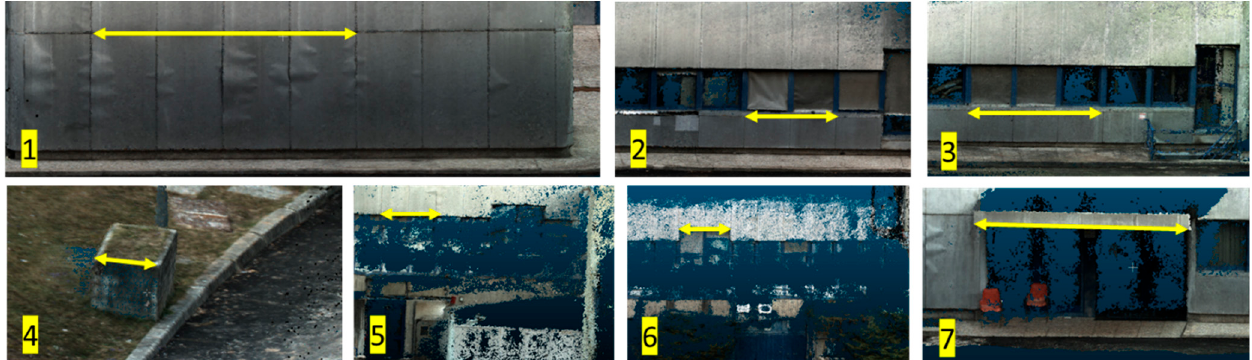
Figure 12. Histogram and distribution of the signed Euclidean distances [m] between the reference mesh and the dense point clouds obtained, respectively, with ( a ) the SLAM-based camera poses and ( b ) the standard photogrammetric pipeline.